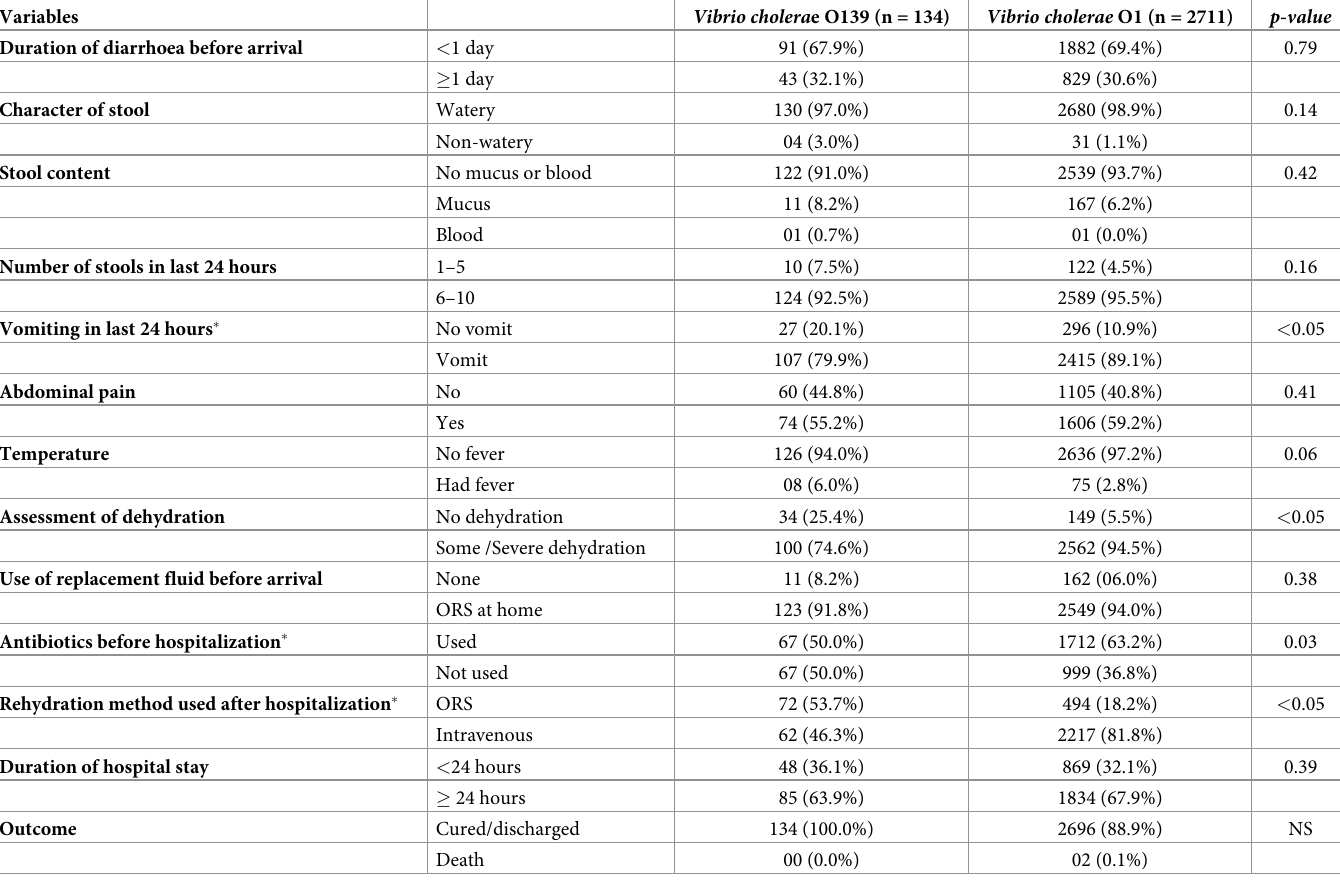
Table 3. Clinical characteristics of patients from whom Vibrio cholerae O139 and Vibrio cholerae O1 strains were isolated among those who attended to the Dhaka Hospital of icddr,b; Bangladesh (2011–2020). Variables